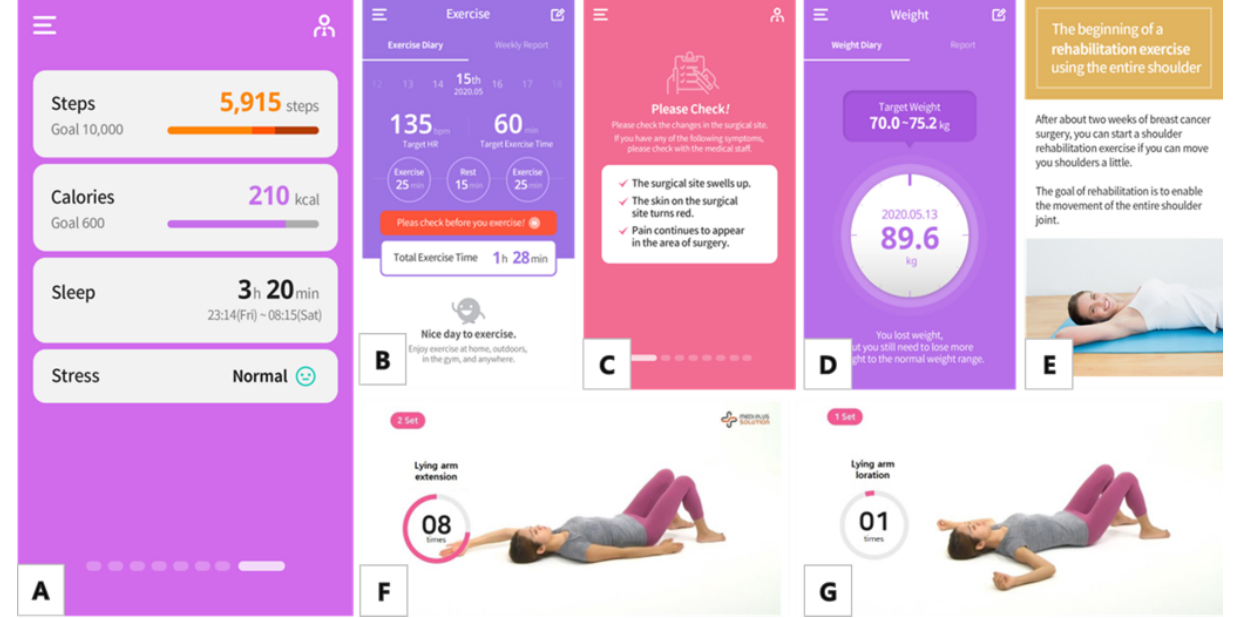
Figure 3. Screenshots of the representative app functionality: (A) self-monitoring, (B) exercise management, (C) main (today’s to-do list), (D) weight management, (E) personalized education and information, and (F) arm and (G) shoulder